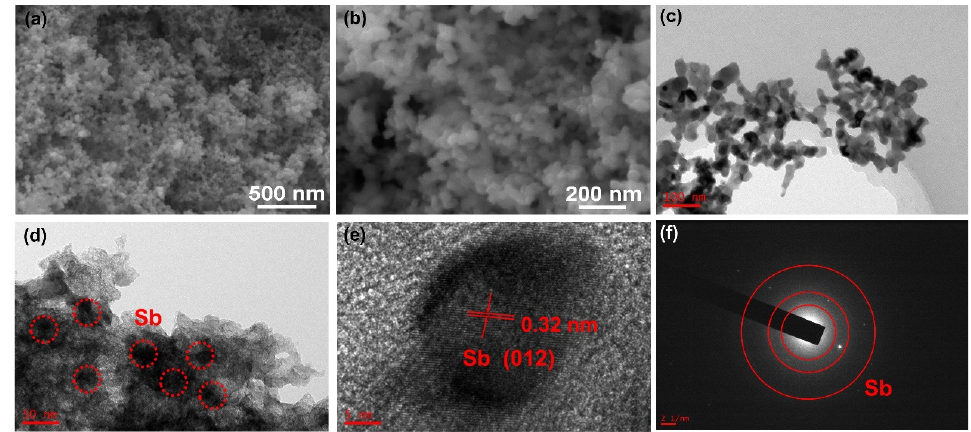
Figure 3. ( a – c ) SEM images at different magnifications of MOF ‐ Sb–C. ( d ) The EDX surface scan area and ( e ) the corresponding EDX element results. ( f ) SEM image of MOF ‐ C–Sb and corresponding elemental mapping.